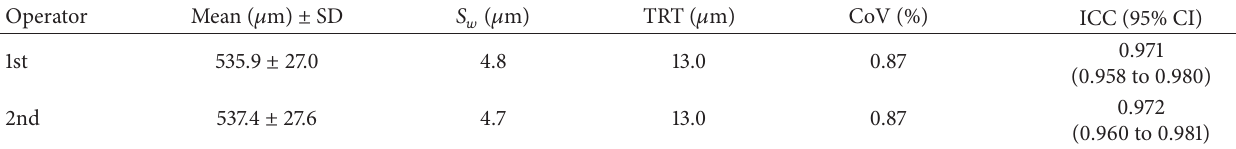
Table 1: Intraobserver repeatability of the corneal dynamic Scheimpflug analyzer Corvis ST in measuring central corneal thickness ( 𝑁 = 84 ). Operator Mean ( 𝜇 m) ± SD